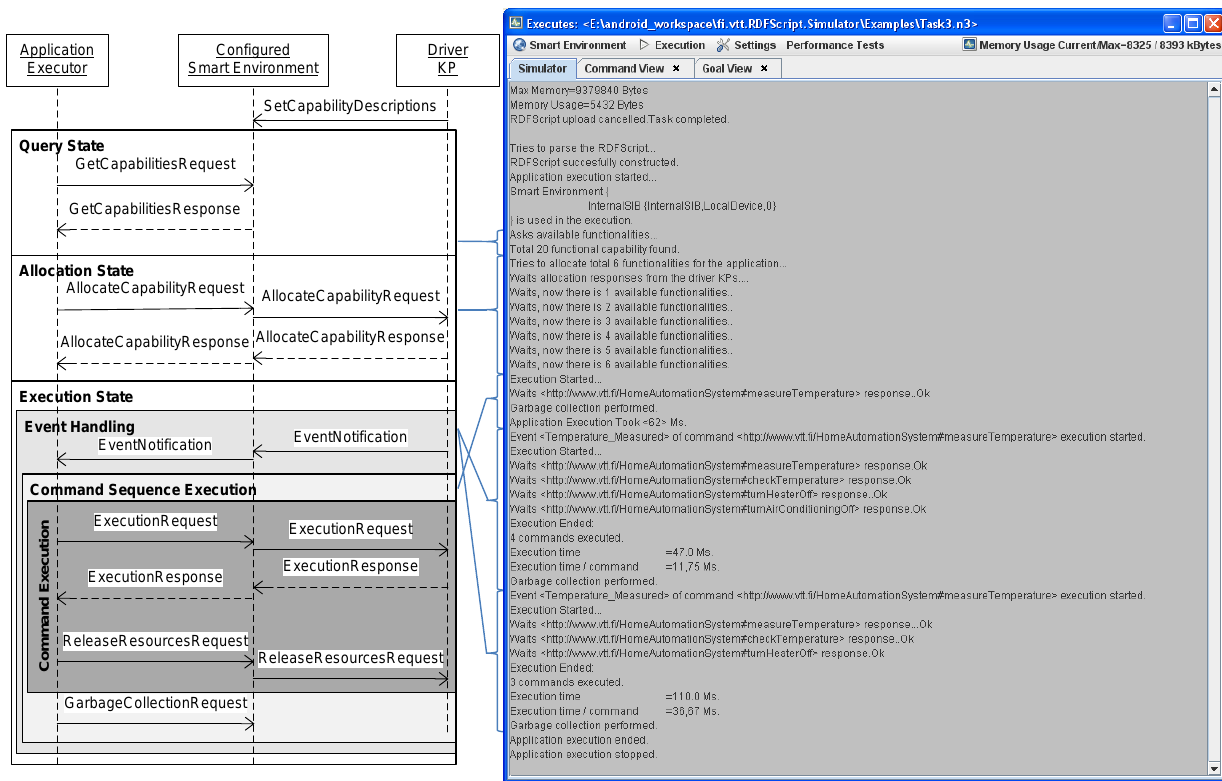
Figure 7. The execution of an application in the RDFScript